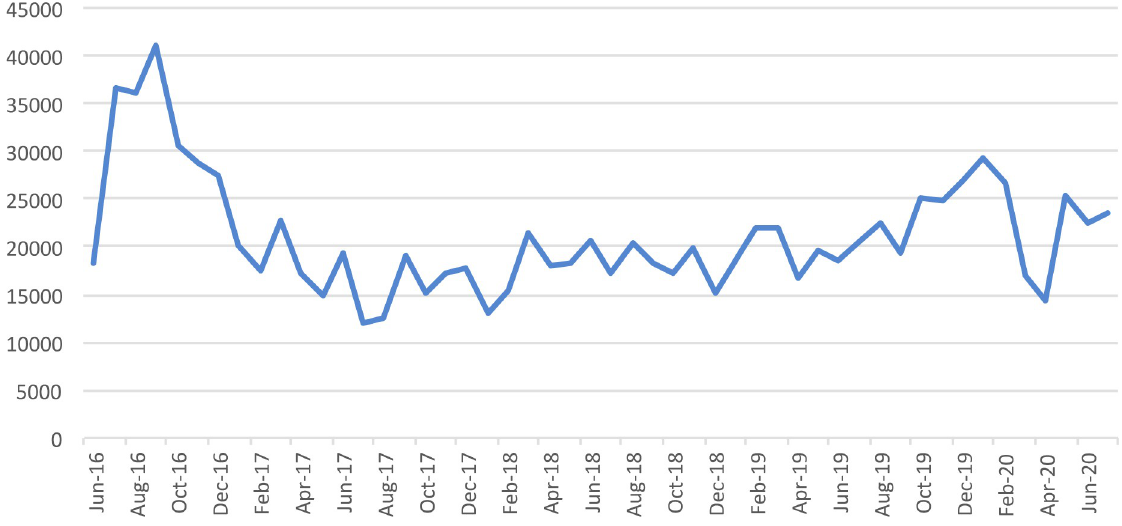
Fig 2. Total reported consultations at the centers hosting refugees/asylum seekers, for all causes, per month.